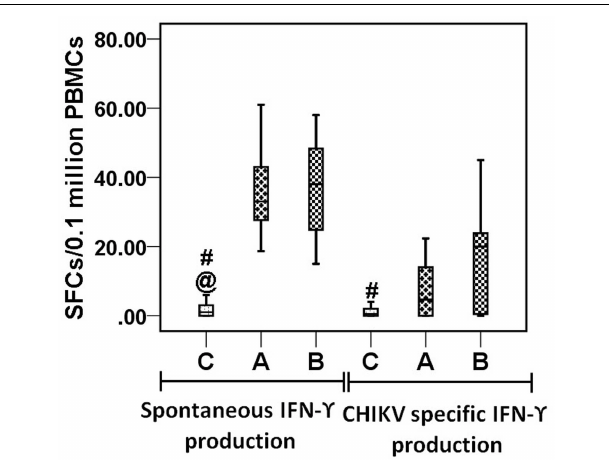
FIGURE 6 | IFN- γ responses by ELISPOT. Box plots are showing IFN- γ responses by PBMCs from 18 control subjects, 13 acute, and 15 convalescent patients, stimulated with CHIK antigen (inactivated CHIKV 10 µ g/10 6 PBMCs). Y axis is showing spot forming cells (SFCs) per 10 5 million cells. Plot shows IFN- γ responses by unstimulated PBMCs before subtraction from stimulated PBMCs well (spontaneous IFN- γ production) and after subtraction of spots in unstimulated PBMCs well from stimulated well (CHIKV specific IFN- γ production). Non-parametric Kolmogorov–Smirnov test was used for intergroup comparison. p < 0 . 05 is considered